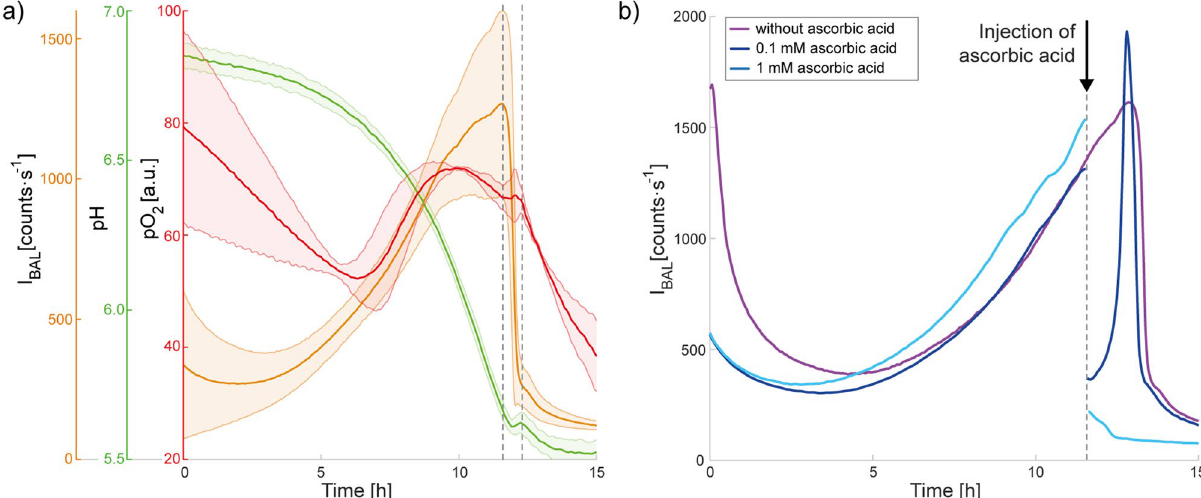
Figure 4. ( a ) Spontaneous BAL of yeast measured in a bioreactor together with the change in pH and pO 2 (average from 3 measurements with a standard deviation). Dashed vertical lines around the twelfth hour delimit the sharp decrease of the BAL intensity and corresponding changes in pH and pO 2 . ( b ) Influence of various concentrations of the antioxidant ascorbic acid (0–1 mM) on spontaneous BAL of yeast. The initial concentration of the sample was 5 · 10 5 cells mL − 1